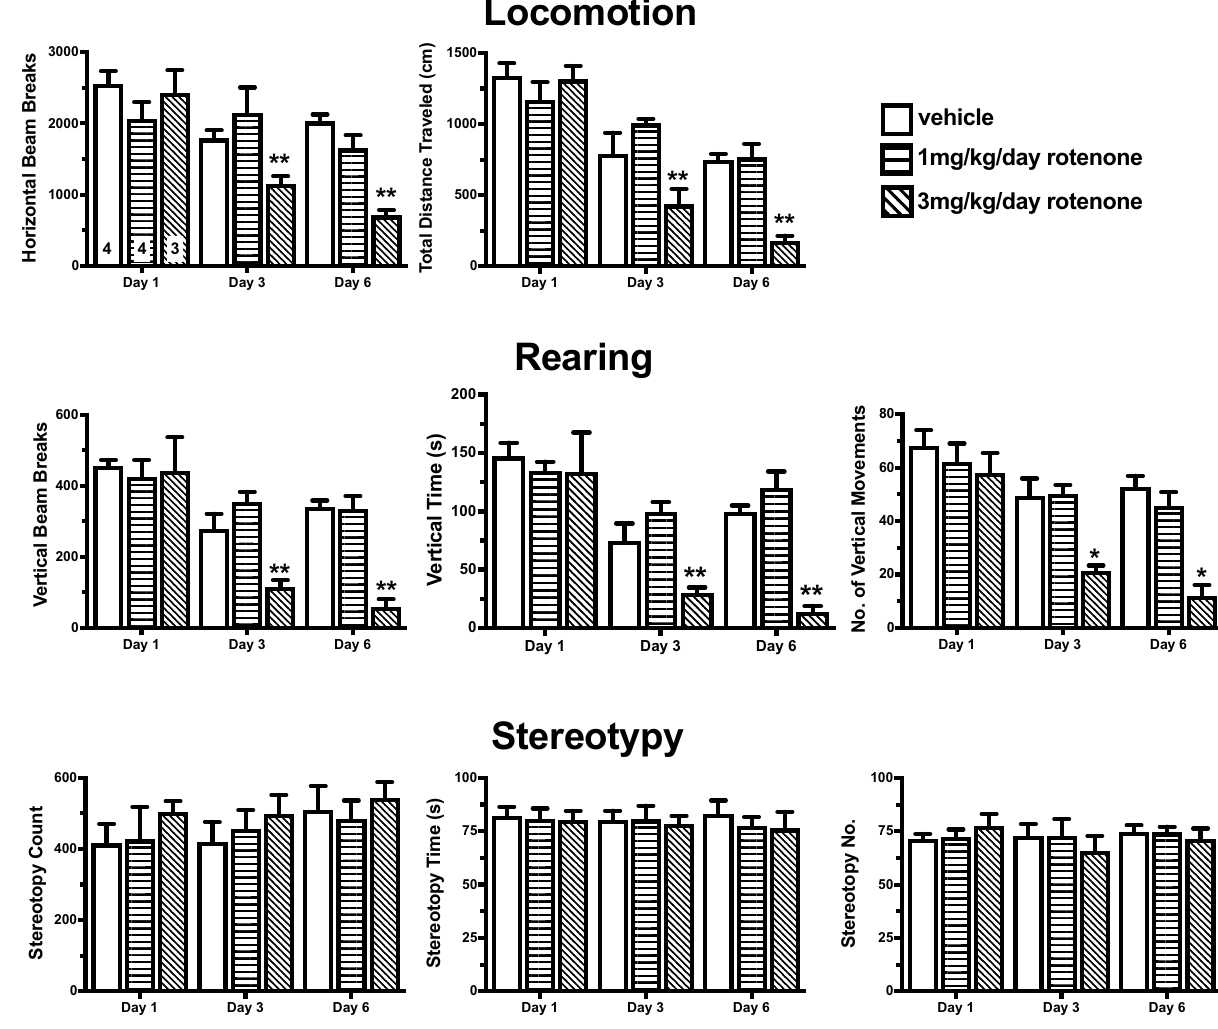
Figure 2. Rotenone dose–response study. Vehicle or rotenone (1 mg/kg/day or 3 mg/kg/day) was administered for 6 days via a subcutaneous osmotic minipump. Assessments of locomotion, rearing and stereotypy were conducted on days 1, 3 and 6. Locomotion and rearing behaviors were significantly decreased in rats treated with 3 mg/kg rotenone on days 3 and 6. There was no effect of rotenone on stereotypy behaviors. One-way ANOVA with a Dunnett’s post hoc test, * p < 0.05, ** p <